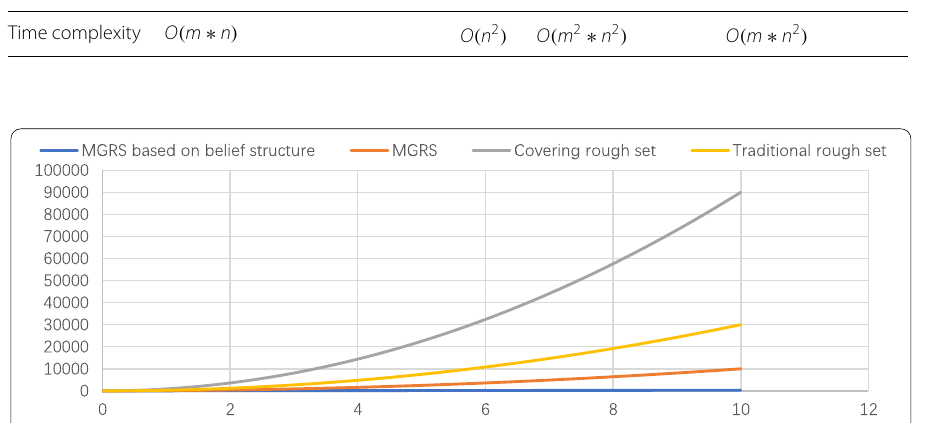
Fig. 4 The comparison of time complexity of different rough set measures with quantitative